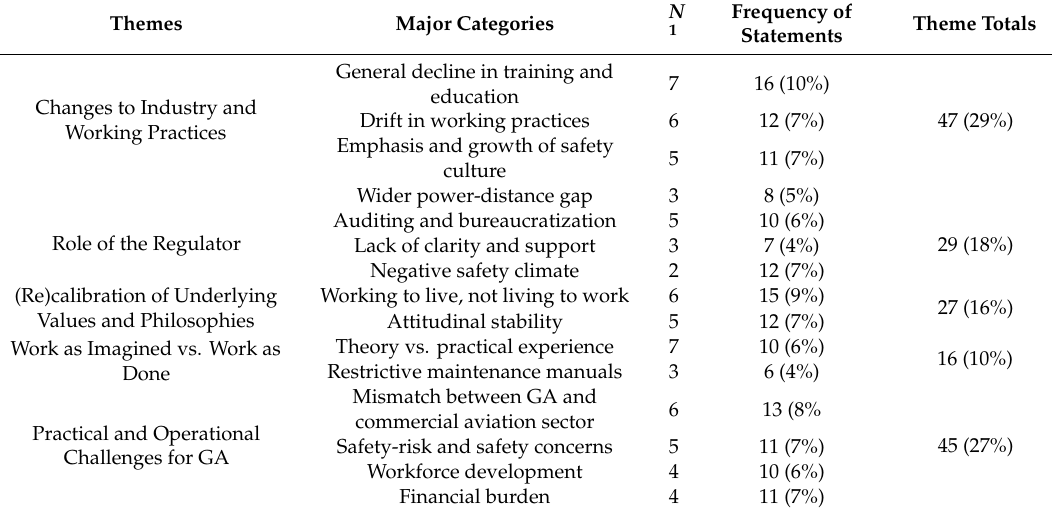
Table 2. Summary of thematic analysis with indication of frequency of statements and theme